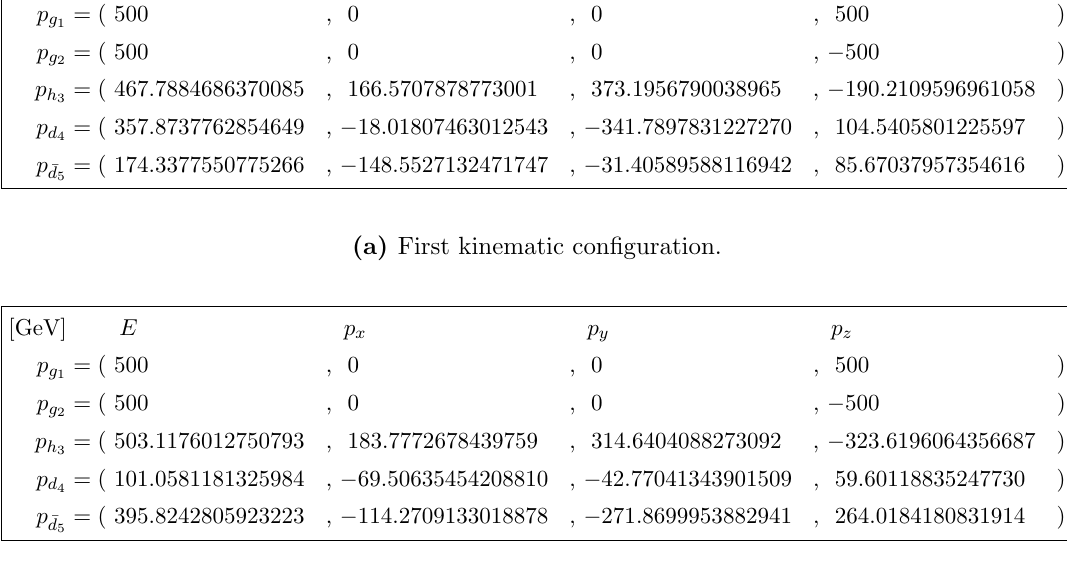
Table 4 . The two kinematic con(cid:12)gurations used for the evaluation of the the process gg